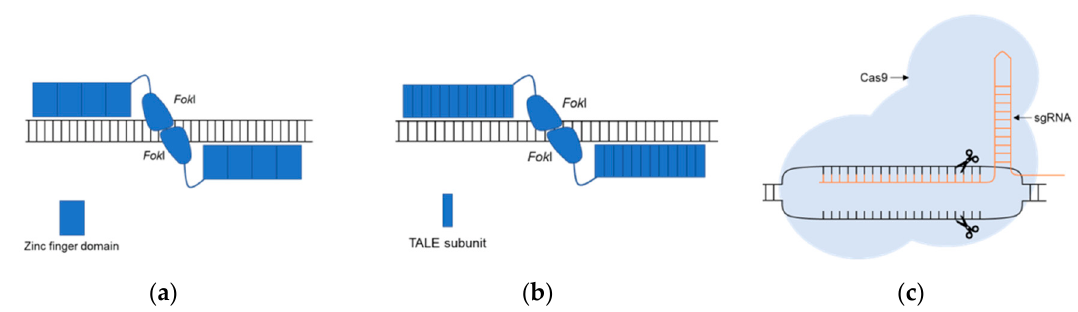
Figure 3. The main genomic editing systems available at the moment. ( a ) Zinc Finger Nucleases—ZFNs: two zinc finger nucleases act as a dimer, each one harboring a DNA binding domain and a DNA cleaving domain Fok I; ( b ) Transcription Activator-Like